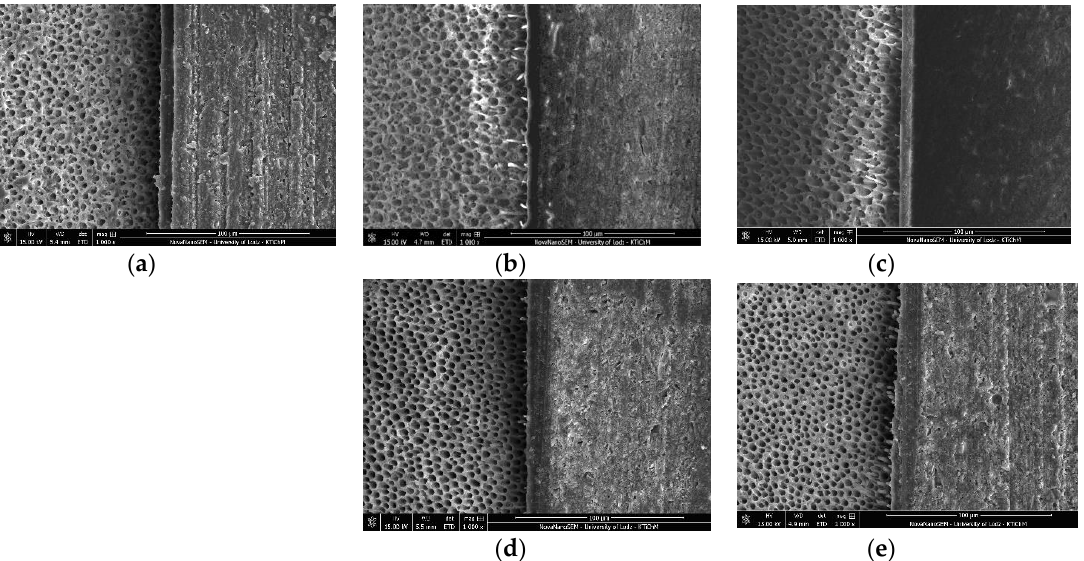
Figure 2. SEM micrographs of dentin specimens treated with Xeno V: ( a ) 1A20 (control); ( b ) 2A20; ( c ) 3A20; ( d ) 2A40; ( e ) 3A60; mag. 1000 x.